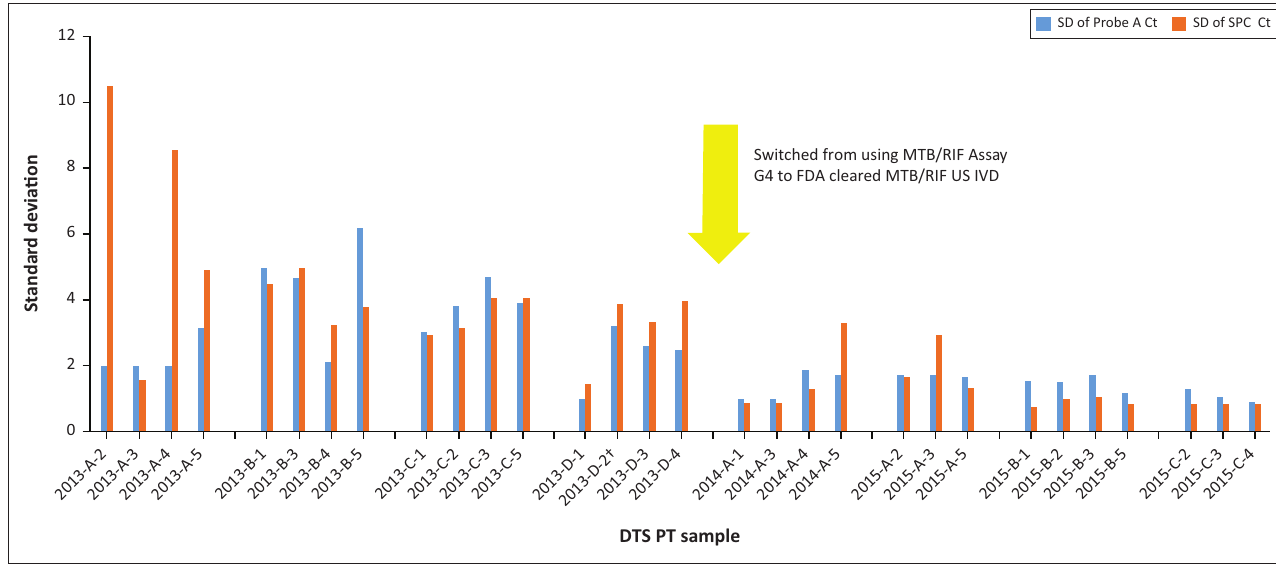
FIGURE 3: Standard deviations of Probe A and specimen processing control cycle threshold values for dried tube specimens containing Mycobacterium tuberculosis complex tested during panel validation, 2013–2015, United States Centers for Disease Control and Prevention (Atlanta, Georgia, United States).